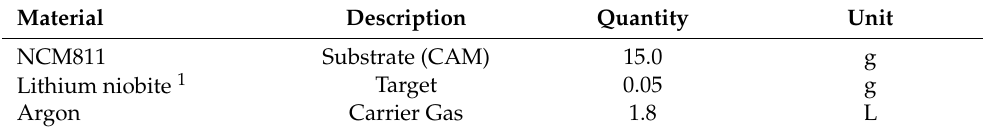
Table 3. Input Materials